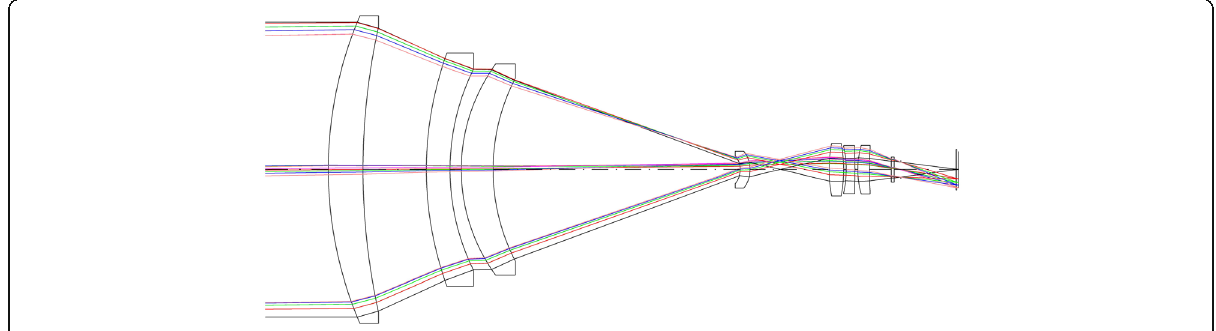
Fig. 3 Optical system diagram of the test